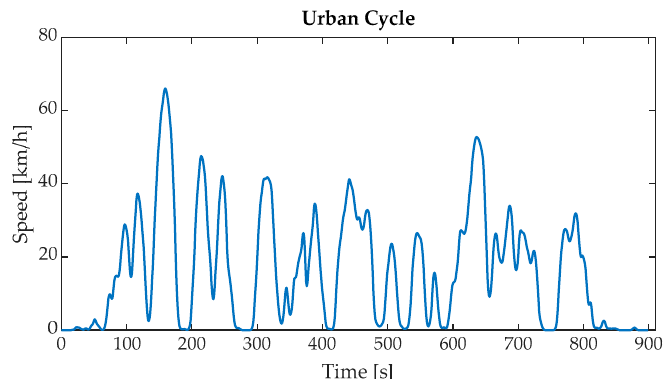
Figure 3. Speed profile of the urban real ‐ world drive mission.